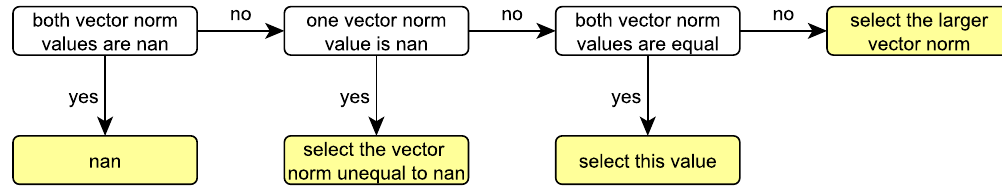
Figure 3. Decision tree to choose the common vector norm for the common evaluation of the two cameras, with nan: not a number. White: properties of both vector norm values. Yellow: selected value.